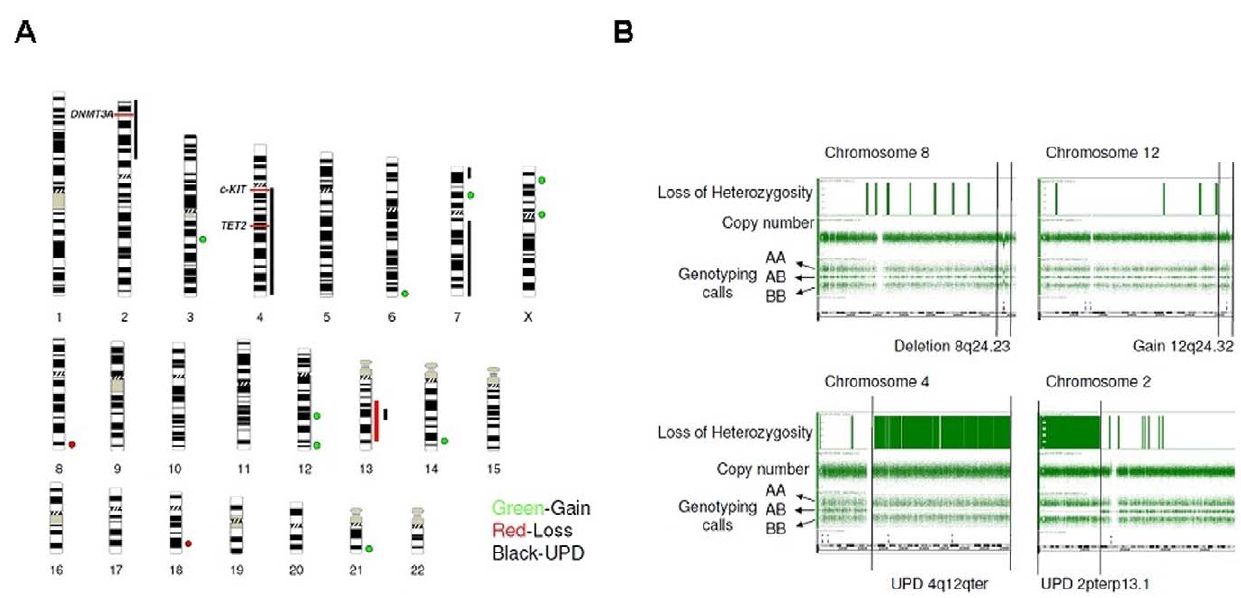
Figure 1. Single nucleotide polymorphism array-based karyotyping (SNP-A) of mastocytosis patients . (A) Overview of all genetic aberrations found by SNP-A analysis in patients with systemic mastocytosis. Green represents gain, red represents loss, black represents somatic uniparental disomy (UPD). UPD involving the KIT and TET2 genes on chromosome 4q and UPD involving the DNMT3A gene on chromosome 2p were noted in one patient each, as indicated. (B) Representative SNP-A analysis of loss of heterozygosity (LOH), UPD, and gain by Genotyping Console v3.0. The top track of each panel shows LOH. The second track shows raw copy number for each SNP along the chromosome, while the third track shows allele calls (AA, AB, BB). Each region of genomic change is indicated by vertical black bars.